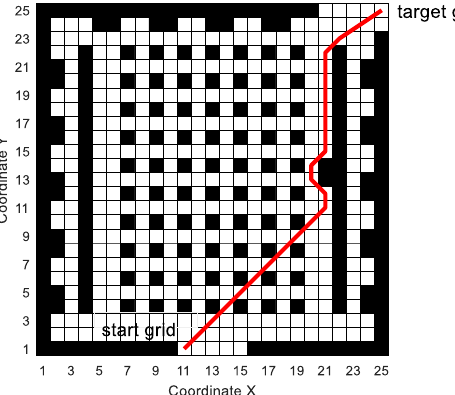
Figure 14. Mobile robot uses MPMGA for local path replanning.